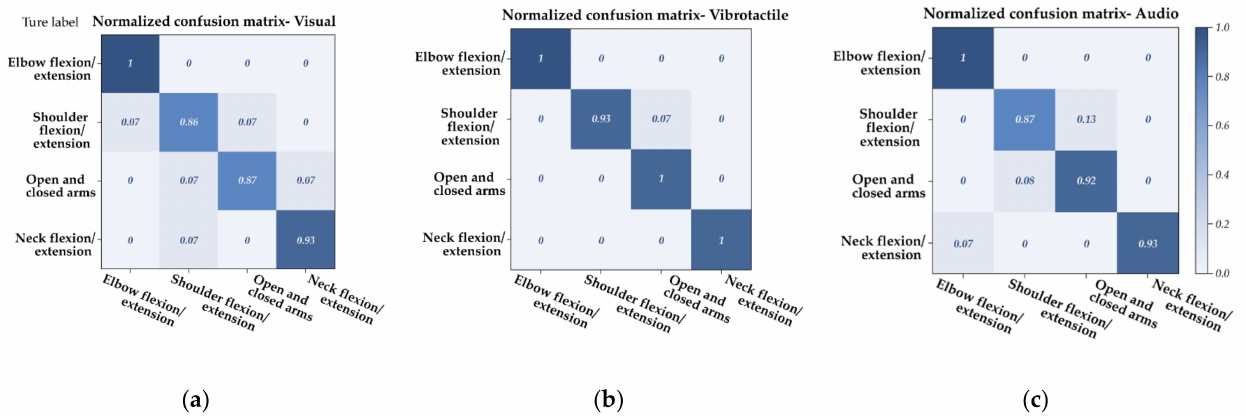
Figure 7. The normalized confusion matrix results for movement recognition of the E-motionWear prototype: ( a ) visual, ( b ) vibrotactile, and ( c ) audio feedback mechanisms.